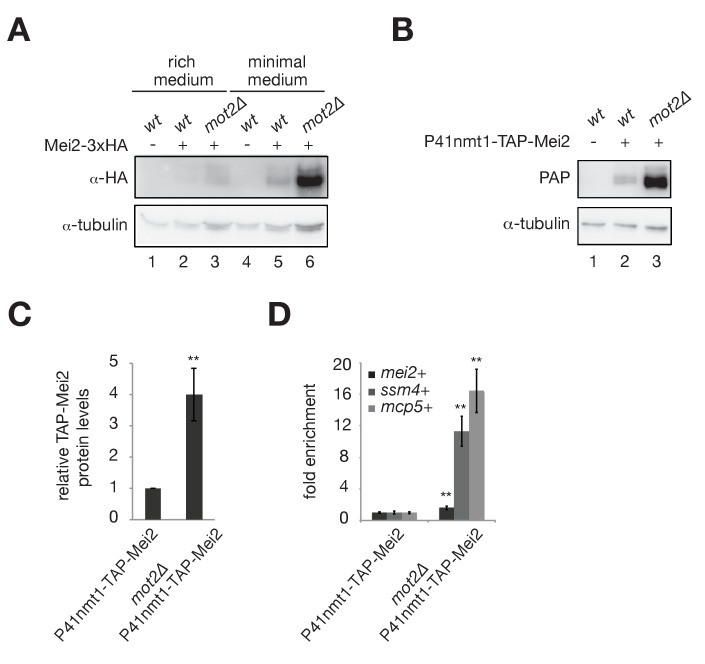
The E3 ubiquitin ligase Mot2 negatively affects the levels of the Mmi1 inhibitor Mei2.(A) Western blot showing total Mei2-3xHA levels in wt and mot2∆ cells grown at 30°C to mid-log phase in rich (YE) and minimal (EMM0.5X) media. An anti-tubulin antibody was used as a loading control. (B) Western blot showing total TAP-Mei2 levels expressed from the P41nmt1 promoter in wt and mot2∆ cells grown in minimal medium (EMM0.5X). An anti-tubulin antibody was used as a loading control. (C) Quantification of TAP-Mei2 protein levels, normalized to tubulin and expressed relative to wt cells. Error bars represent the standard deviation from five independent experiments. Stars denote statistical significance (t-test p-value=1.38E-3). (D) RT-qPCR analysis of mei2+, ssm4+ and mcp5+ transcripts in wt and mot2∆ strains expressing Mei2 from the P41nmt1 promoter. Cells were grown in minimal medium (EMM0.5X). Signals were normalized to act1+ mRNA levels and expressed relative to the P41nmt1-TAP-Mei2 strain. Error bars represent the standard deviation from four independent experiments. Stars denote statistical significance (t-test p-values: mei2+ = 8.5E-3; ssm4+ = 1.53E-3; mcp5+ = 1.49E-3).